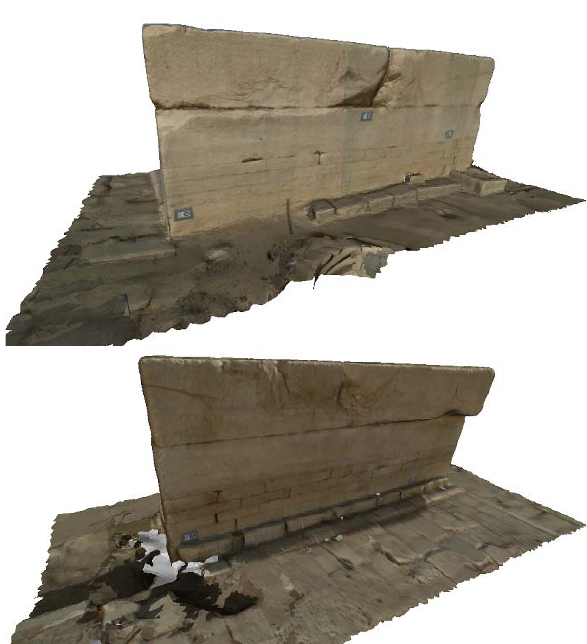
Figure 6. Overview of the photographs used for automatic texture mapping of the Sabaean inscription stone at the Almaqah temple in Sirwah (Yemen)